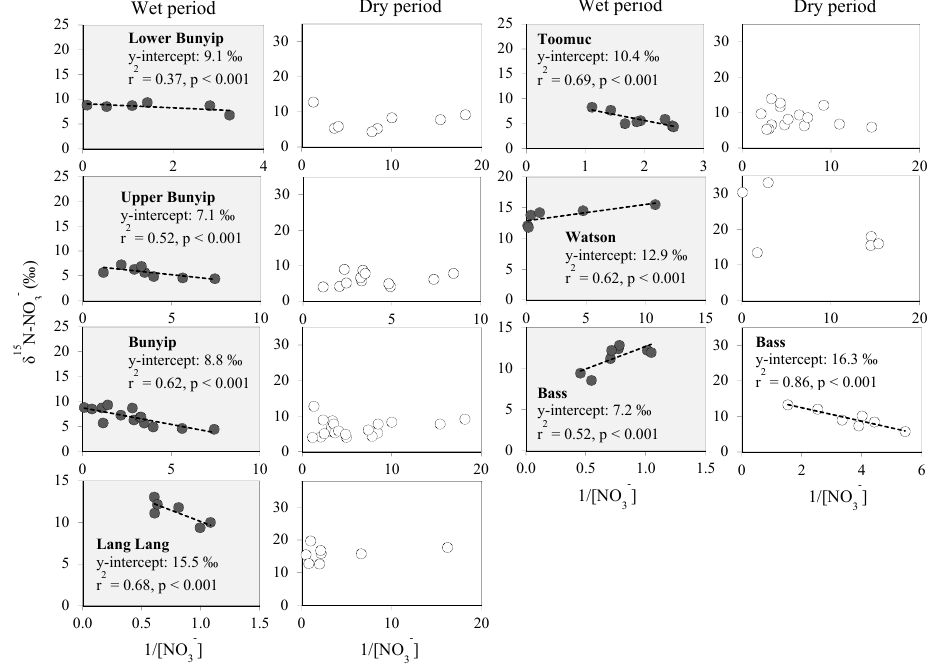
Figure 6. Relationship between δ 15 N–NO −